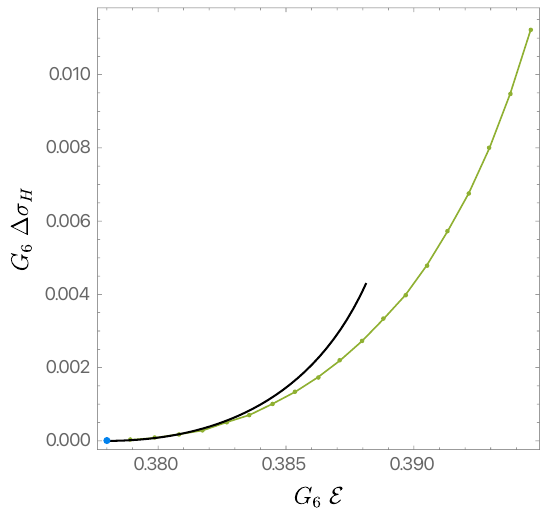
Figure 5 . Comparison between nonlinear solutions and the perturbative results of section 4. The solid black line is the perturbative expansion, whereas the green disks are the full nonlinear results. Both curves were generated with e Ω H = 0 . 66 (though recall that ∆ σ H is the difference with respect to the Myers-Perry black string at the same E and J , so the reference Myers-Perry black string may have a different e Ω H ). The Myers-Perry superradiant onset is the blue disk with ∆ σ H = 0 . The fact that ∆ σ H ≥ 0 indicates that black resonators are the dominant